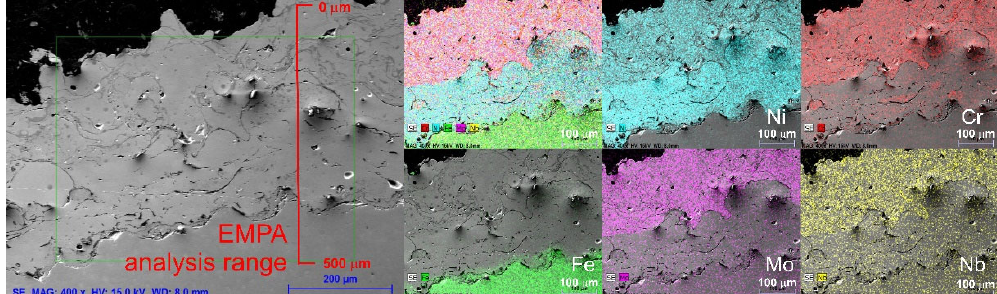
Figure 8. SEM/EDX image of the TWAS pseudo ‐ alloy coating after 5000 h at 600 °C.